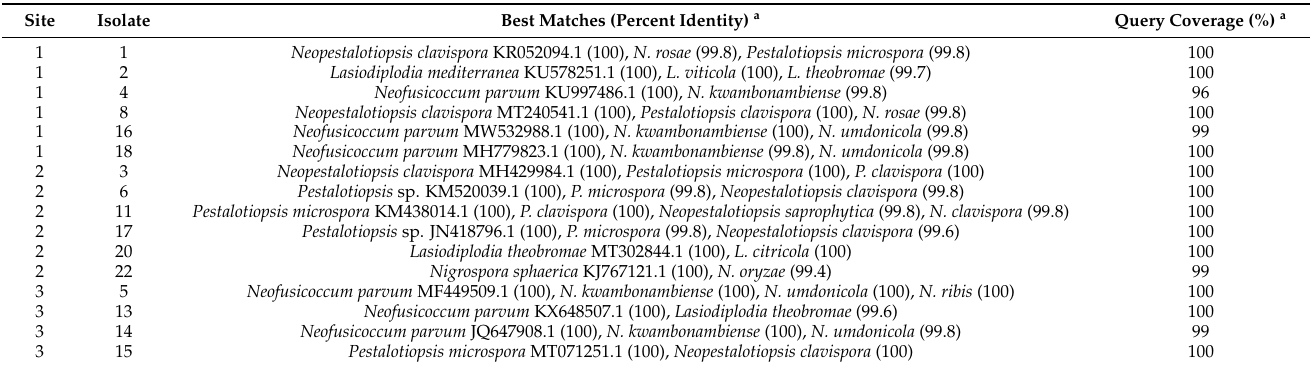
Table 3. BLAST results from ITS sequence comparisons showing example accessions that were highly similar to our isolate sequences obtained from southern highbush blueberry canes with bark inclusions and stem blight symptoms in study